Question: Describe this figure in one sentence.
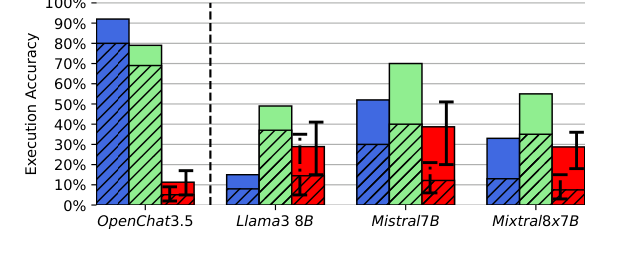
Answer: Transferability of Neural Exec generate for Open- Chat3.5 model across multiple LLMs measured as execution accuracy.